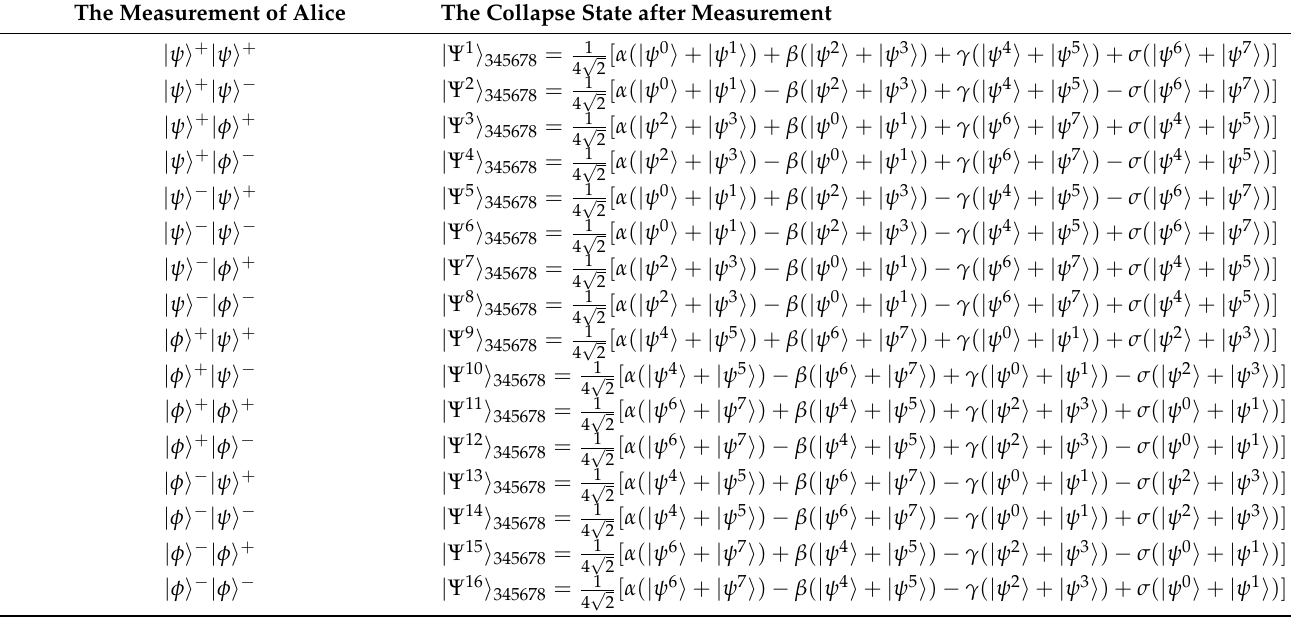
Table 4. Collapse of the remaining particles after Alice performed the measurement. The Measurement of Alice The Collapse State after